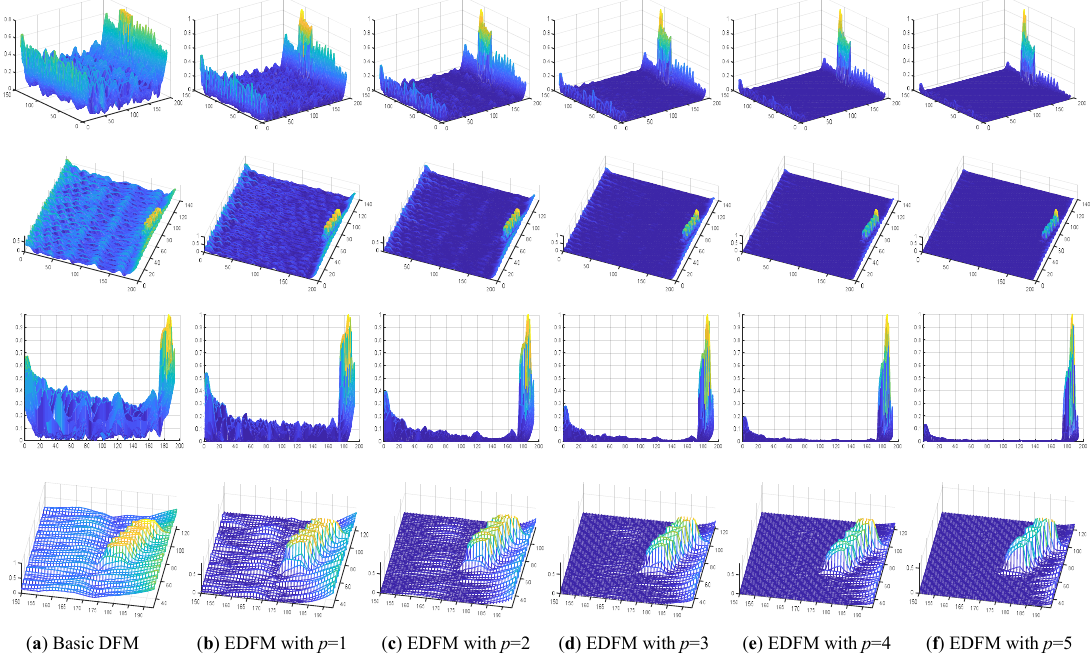
Figure 14. Exhibition of defect enhancement results with different background suppression index p . Rows 1–3 show 3D mesh surfaces of feature maps from different viewing angles, while Row 4 shows 3D mesh surfaces of defects in local